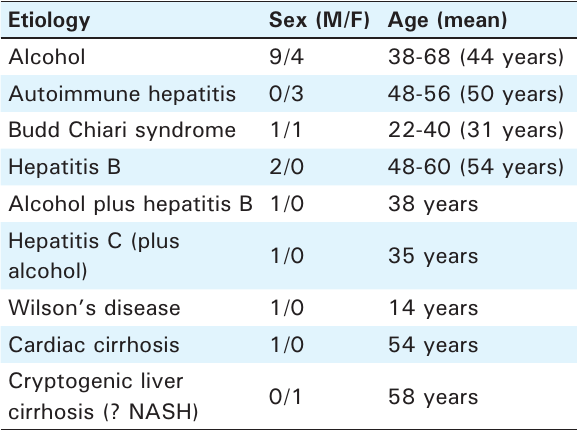
Table 1. Age and sex distribution of the patients